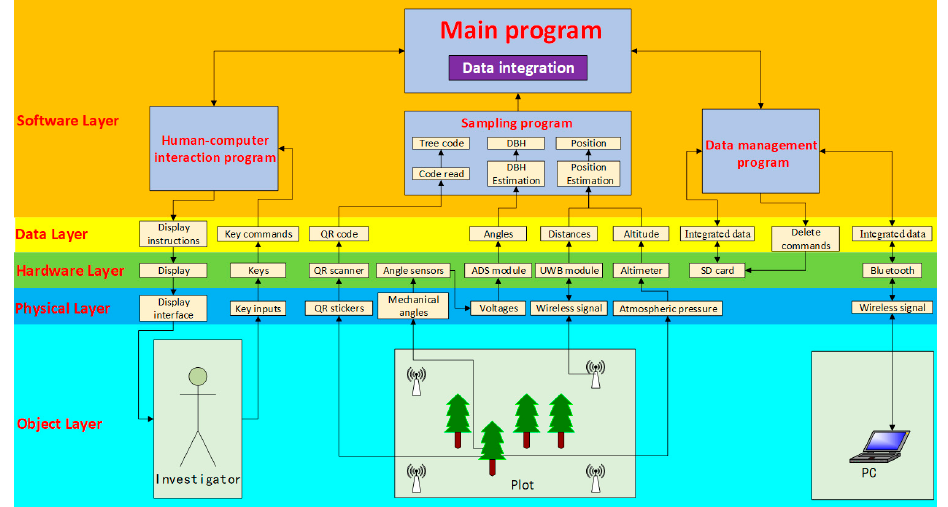
Figure 4. The system workflow of the device for coding trees and estimating diameter.